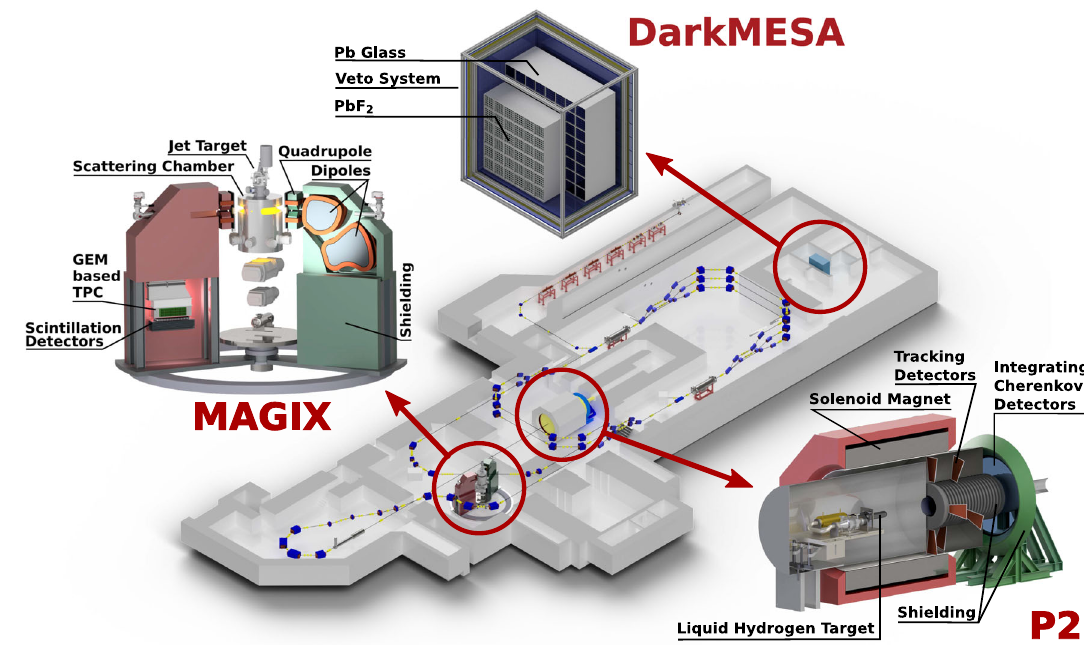
Fig. 44 The MESA accelerator with the three experiments: DarkMESA, MAGIX, and P2